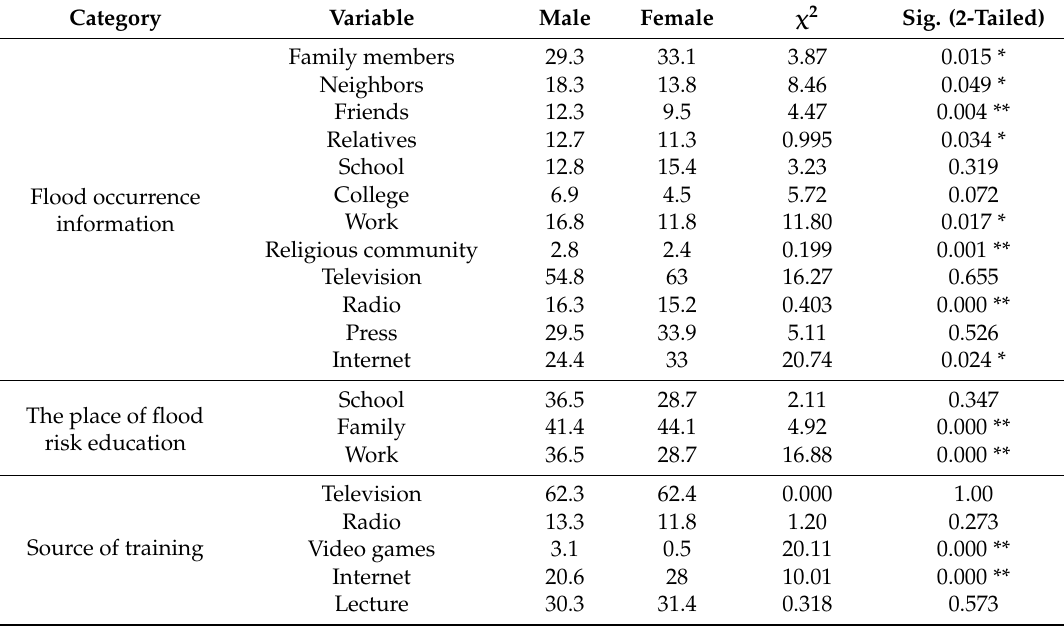
Table 10. Chi-square test results between gender and information and education-predicting variables.